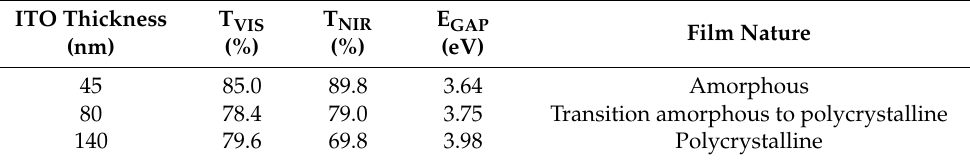
Table 2. Optical parameters of the ITO films deposited at RT, 25 W and 0.17 Pa glass. The nature of the film is also included.